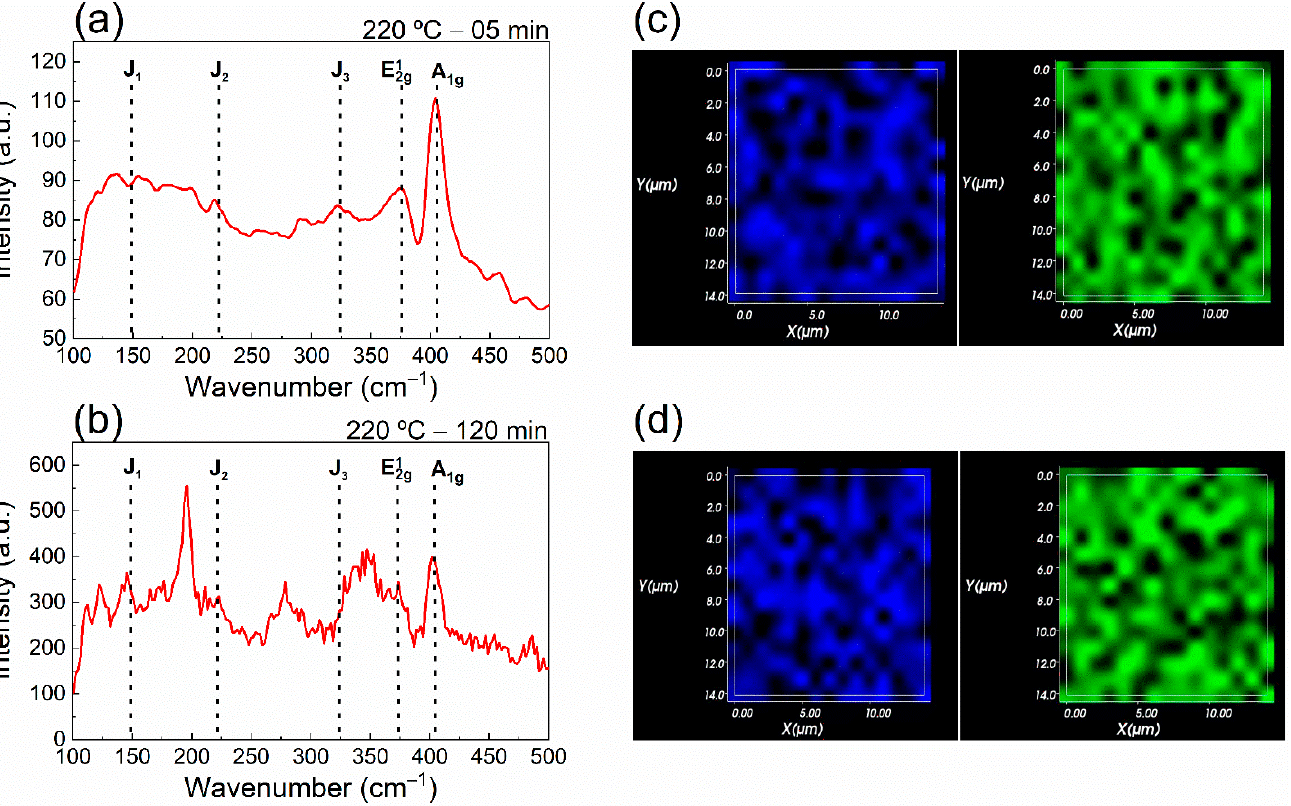
Figure 4. Raman spectra and micro-Raman mapping of the MoS 2 nanosheets synthetized at 220 ◦ C with synthesis times of ( a , c ) for 05 min and ( b , d ) for 120 min. The blue and green mappings represent 1T- and 2H-MoS2 phases in the samples.